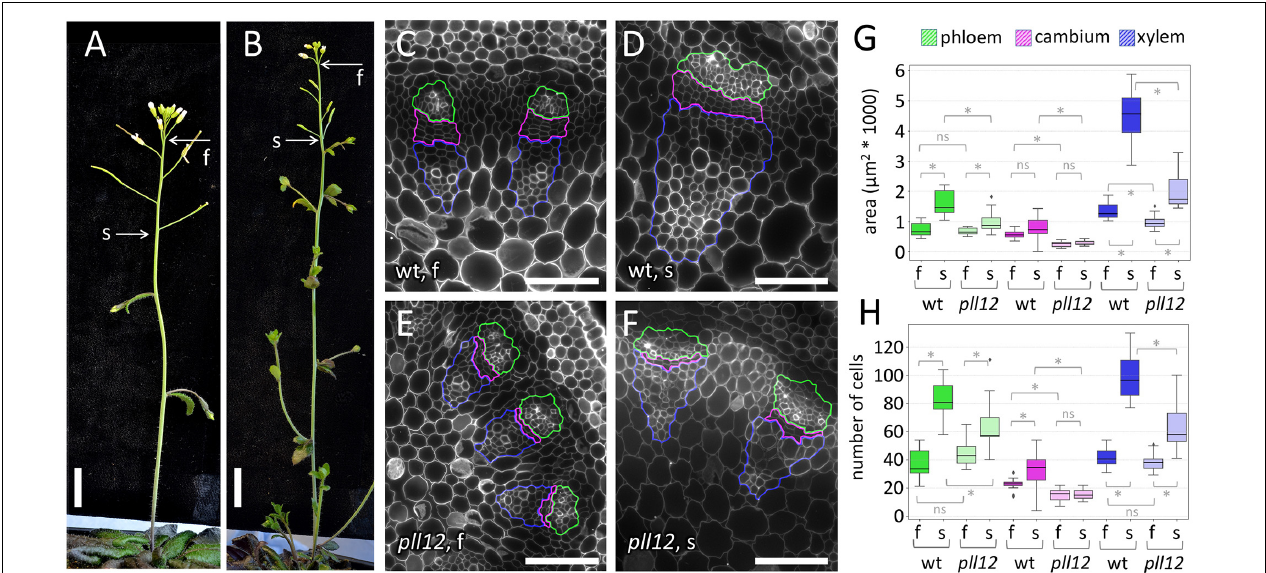
FIGURE 3 | PLL12 is required for growth of the cambium and vascular bundles in the stem. (A,B) : overview of wt (A) and pll12-1 (B) inflorescence stems, with the position of the most mature flower before organ abscission (f) and of the oldest silique (s) indicated; scale bars: 1 cm. (C–F) : calcofluor-stained cross-sections of vascular bundles of wt (C,D) and pll12-1 (E,F) stems, at the position of the most mature flower (C,E) or of the oldest silique (D,F) ; the phloem, cambium and xylem regions are enclosed in green, magenta, and blue lines, respectively; scale bars: 50 µ m. (G,H) : boxplots of the area (G) and cell number (H) within phloem, cambium and xylem regions selected as in (C–F) , comparing vascular bundles at positions f and s in wt and pll12-1 stems; * and ns indicate significant and non-significant differences in pairwise comparisons ( p < 0.05, Mann-Whitney test); Supplementary Table 2 contains a full statistical analysis, including numbers of replicates, p -values and power